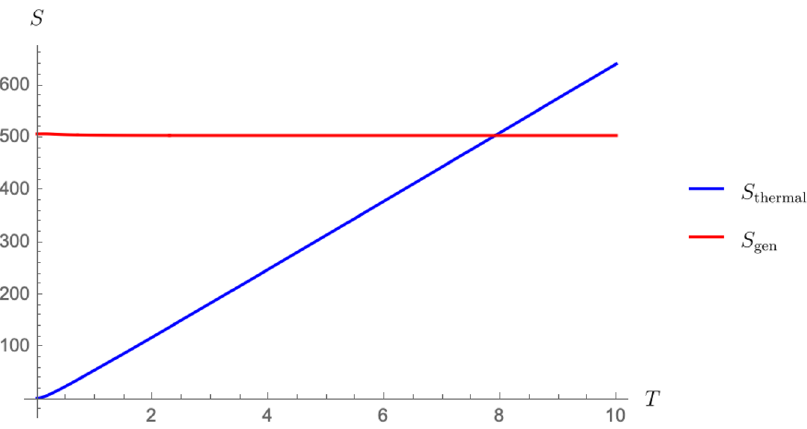
Figure 5 . A plot of the two candidate entropies for S A as a function of the CFT temperature T = 1 /β , with φ 0 = 1000 , φ b = c = 10 , and L = G N = 1 . The blue curve is the thermal entropy of CFT fields on universe A , and corresponds to dominance of the disconnected saddle in the replica trick computation of the entropy. The red curve is the generalized entropy of a complement island on universe B , which corresponds to dominance of the fully connected replica wormhole. The Page curve in AdS (the entropy S A ) is computed by taking the minimum of these two curves. We see that the Page transition occurs around T = 8